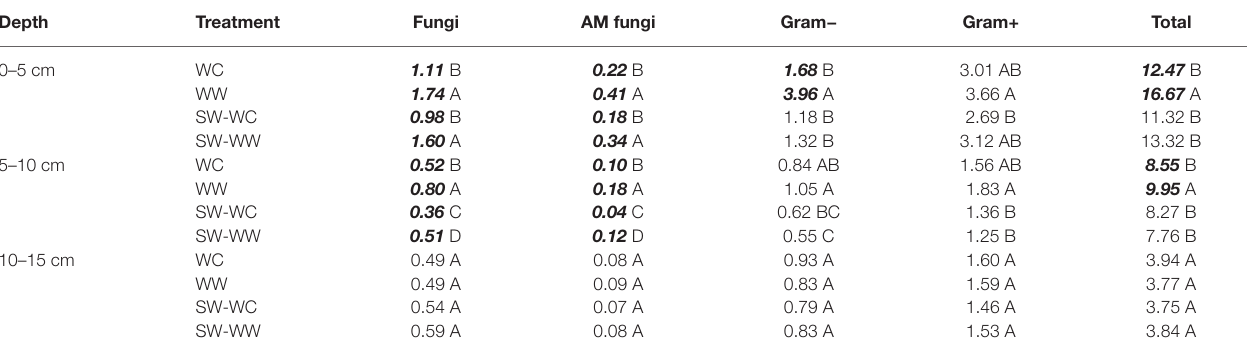
TABLE 1 | Absolute abundance (nmol/g) of microbial lipid groups at 0–5, 5–10, and 10–15 cm depths from crop years